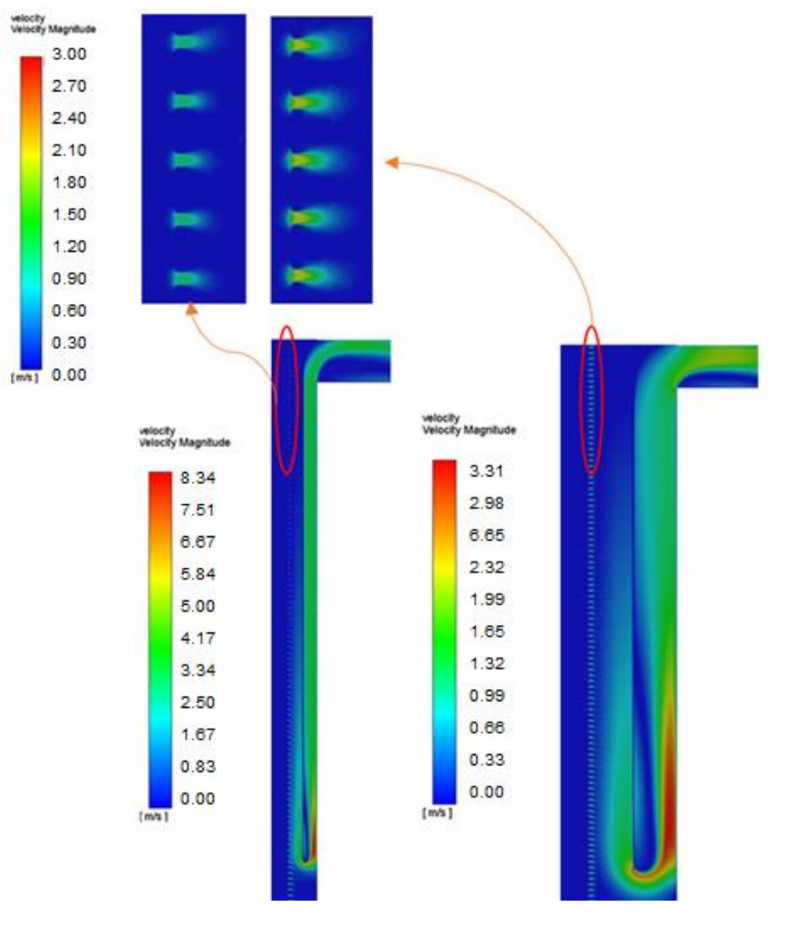
Figure 15. Distribution of the velocity magnitude in a median plane of both DSTSC, 10 cm ( left ) and 30 cm ( right ), for an air flow of 500 m 3 /h.